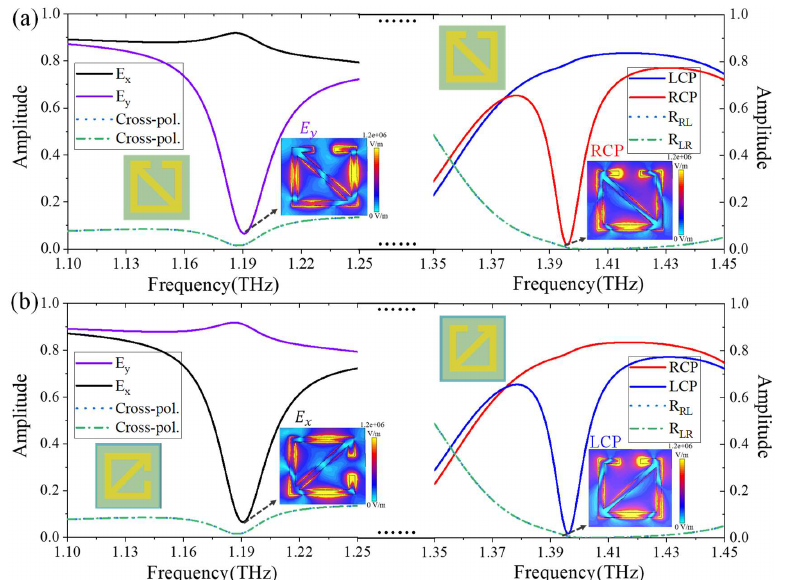
Figure 2. An illustration of the normalized reflection spectrum of different structural units excited by different polarized waves. ( a ) The reflection spectrum of the chiral structural units. ( b ) The reflection spectrum of the complementary structural units.